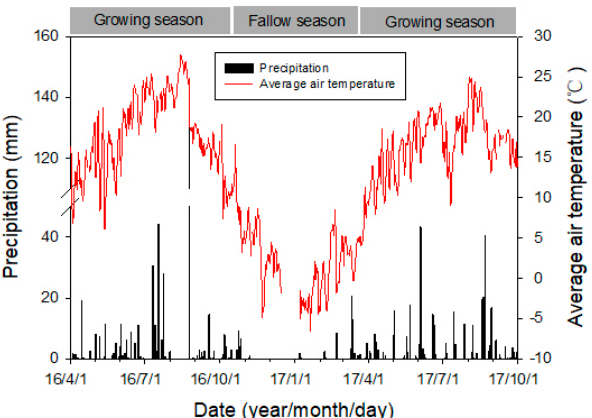
Figure 2. Daily precipitation and average air temperature during field experiments. The black columns represent precipitation and the red line represents average air temperature.